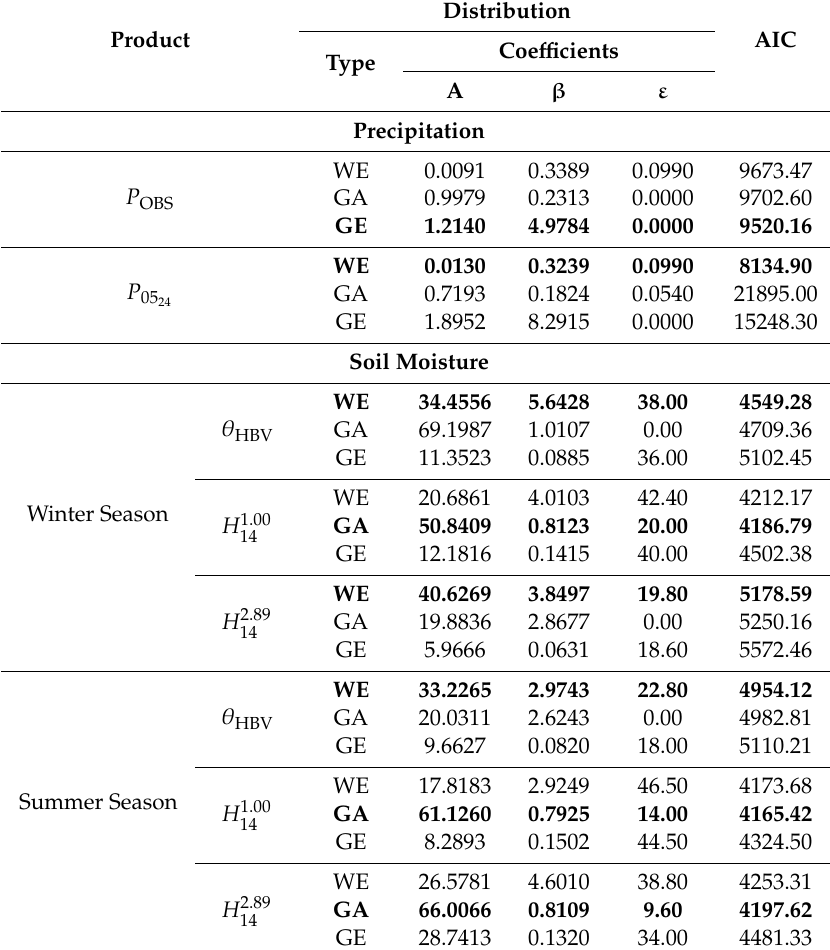
Table 1. Choice of the distribution used in the bias correction of precipitation and soil moisture H-SAF products: P 05 , H 1.00 and H 2.89 based on the AIC (Akaike Information Criterion) with: WE (Weibull), 14 14 24 GA (gamma) and GE (generalized exponential) distribution. Bolded values represent the best fitting